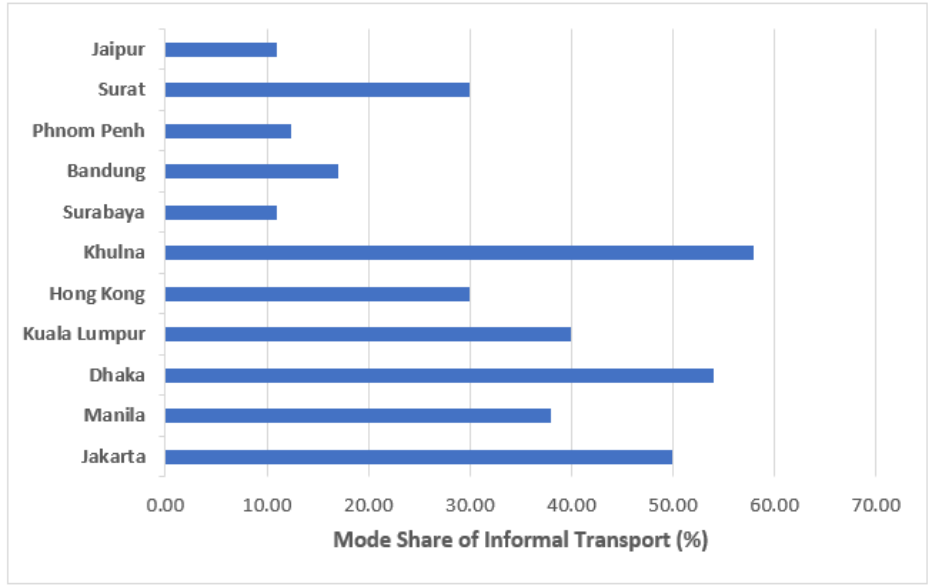
Figure 5. Mode share of informal transport in Asian cities. Source: Compiled from